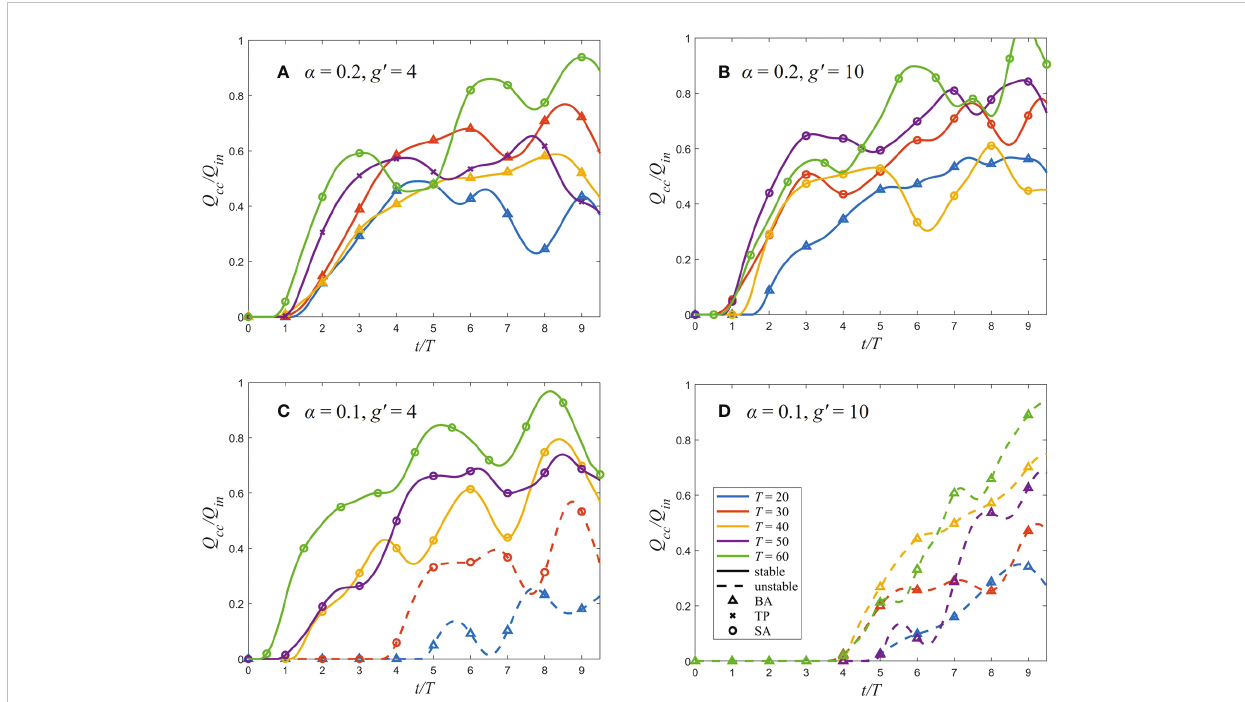
FIGURE 11 Time series of normalized coastal current transport of different rotation rates. (A, B) are steep slope cases, while (C, D) are gentle slope cases. For each line, solid and dash line represent the bulge as stable and unstable, respectively. The triangle, cross and circle symbols mean the plume is bottom-attached, transitional and surface-advected, respectively.